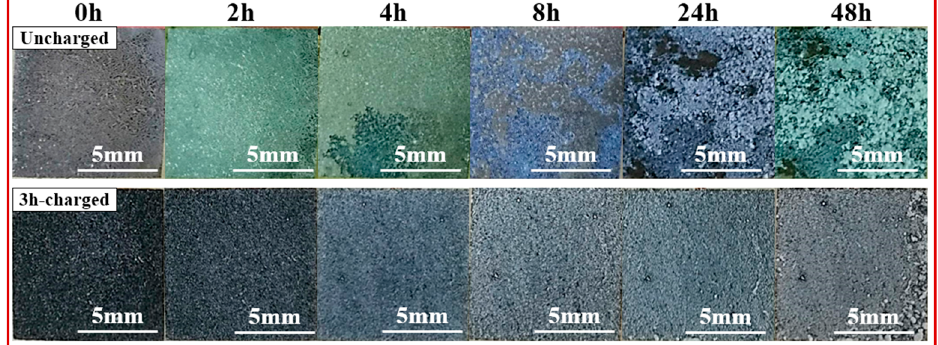
Figure 9. Macro corroded surfaces of the uncharged and 3 h charged samples after being immersed in the 0.1 M NaCl solution for different durations.